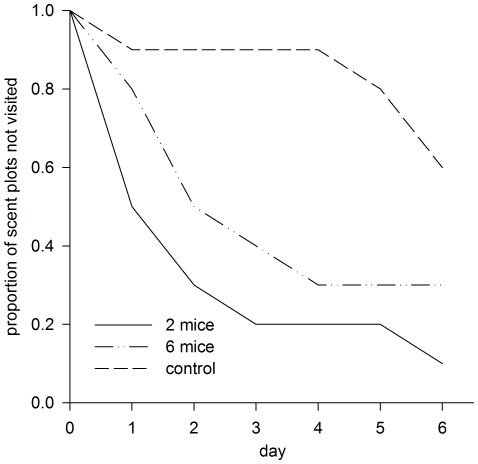
Predators visited mouse-scented plots significantly faster than control-scented plots.Survival analyses revealed that predator visitation rates to the scents of two-mice (solid line) and six-mice (dotted line) were significantly faster than visitation rates to control scents (dashed line). Results are presented as the proportion of plots remaining not visited over time in each treatment.